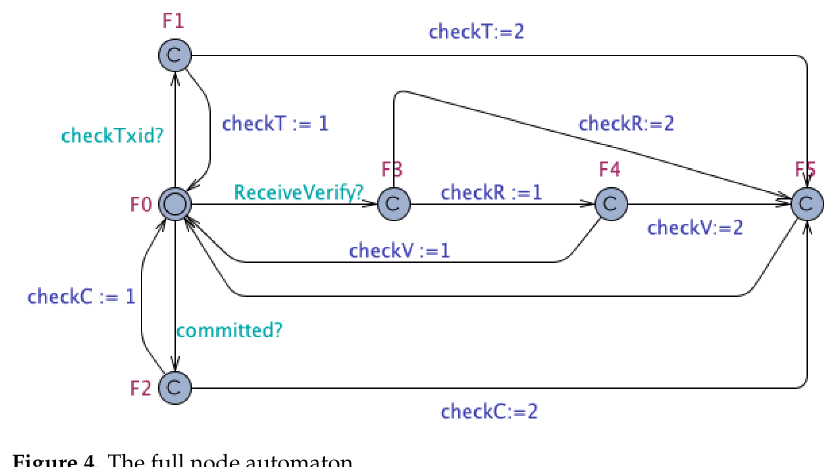
Figure 4. The full node automaton.